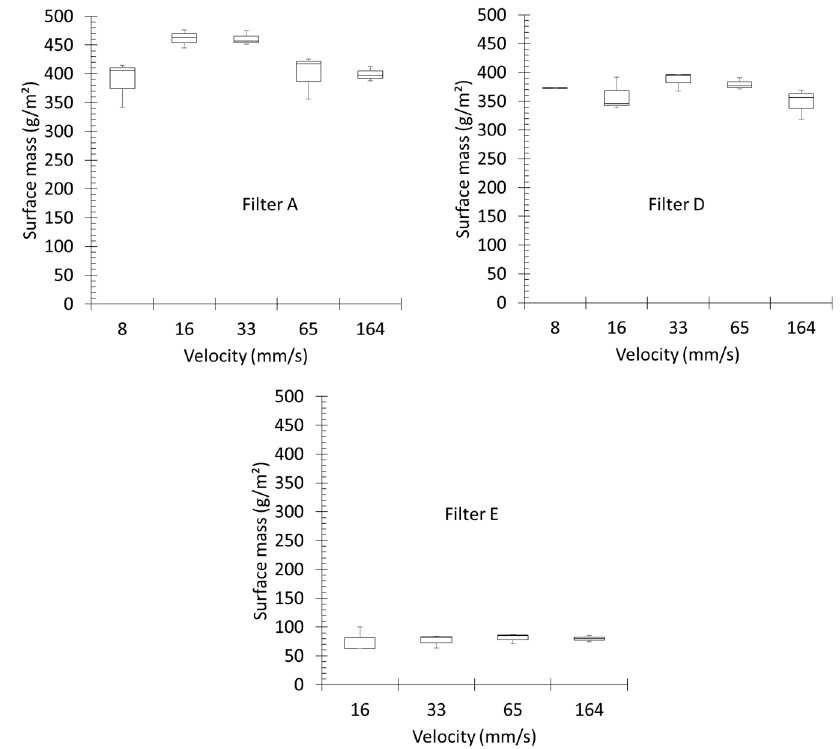
Figure 7. Evolution of the liquid surface mass at saturation as a function of the face velocity.